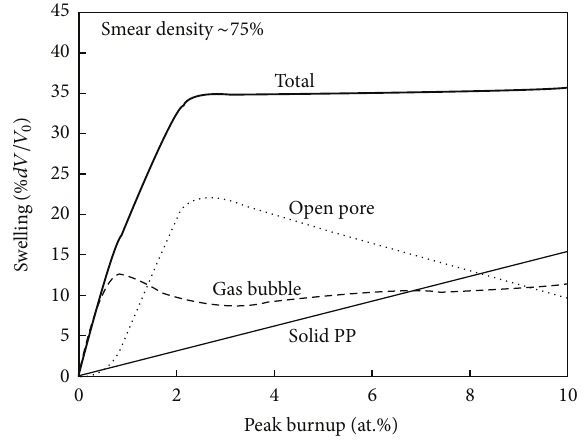
Figure 9: Radial swelling versus burnup for metallic